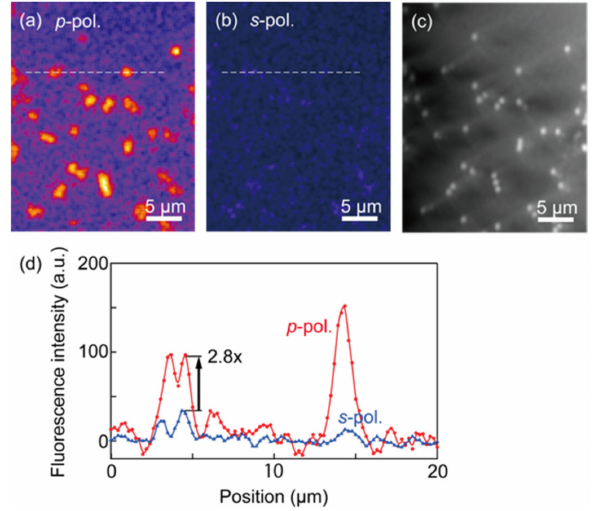
Figure 4. The fluorescence images of water-immersed polystyrene latexes excited with ( a ) p - polarization, ( b ) s -polarization, ( c ) conventional reflection image and ( d ) the fluorescence intensity line profiles between p -polarization and s -polarization fluorescence images.